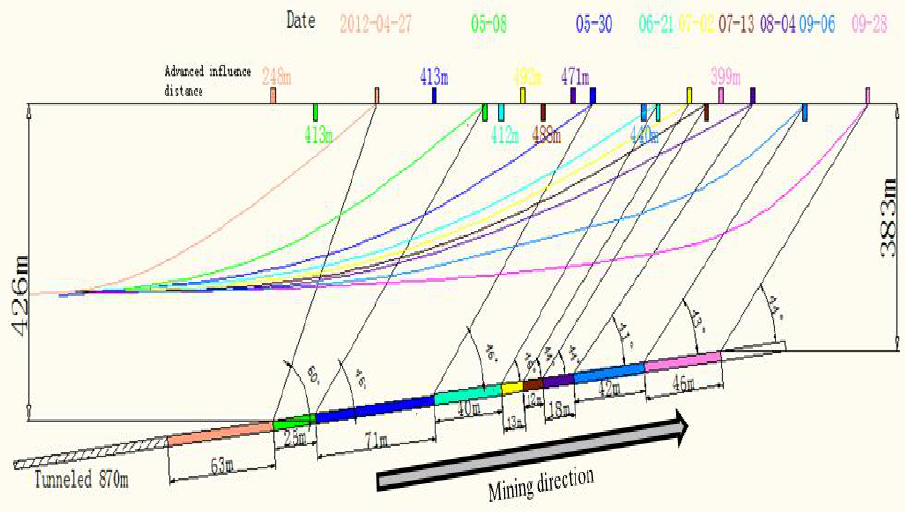
Figure 10. Expansion of subsidence trough caused by the 18207 working face.